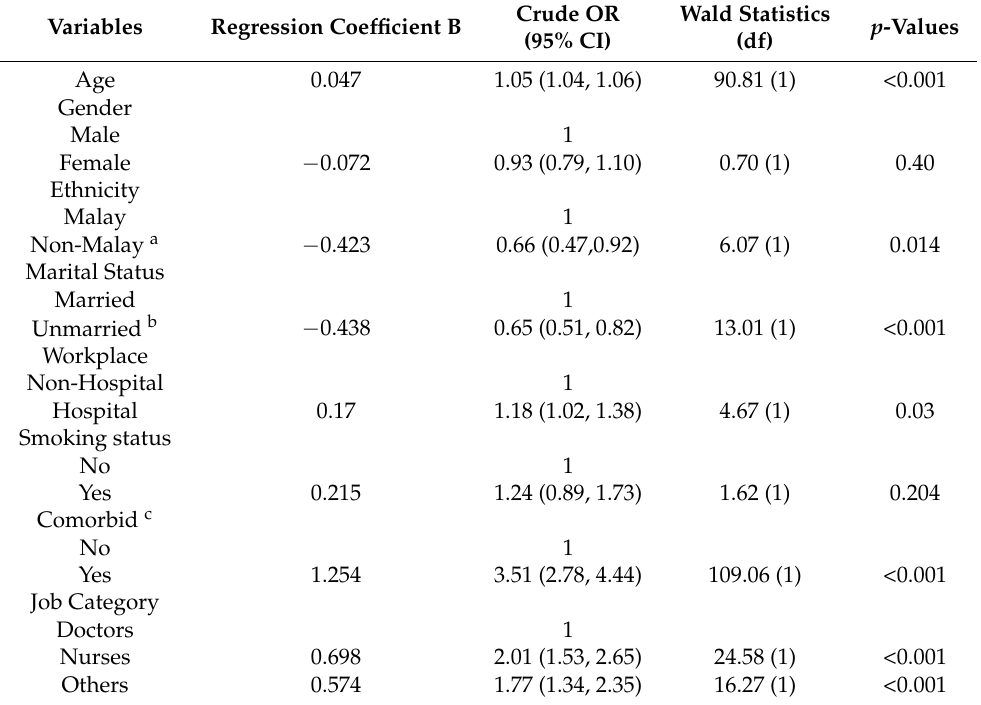
Table 4. Simple logistic regression of the association between each variable and HCWs’ obesity status ( n =